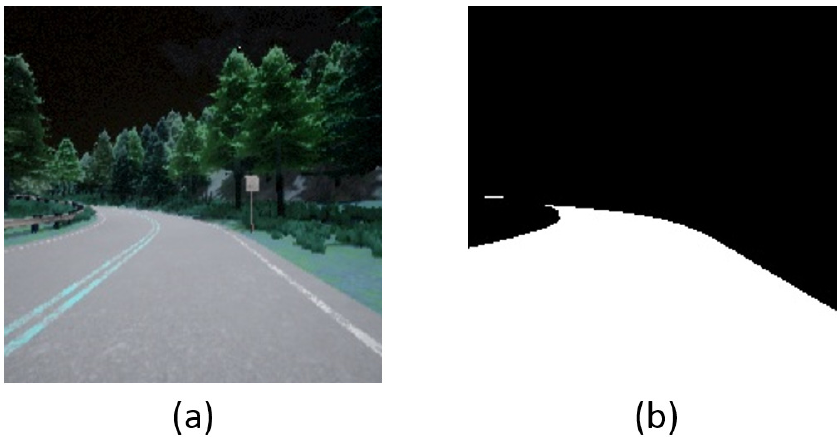
Figure 4. An example of driving vision to obtain A road : ( a ) Original; ( b ) Binarization.